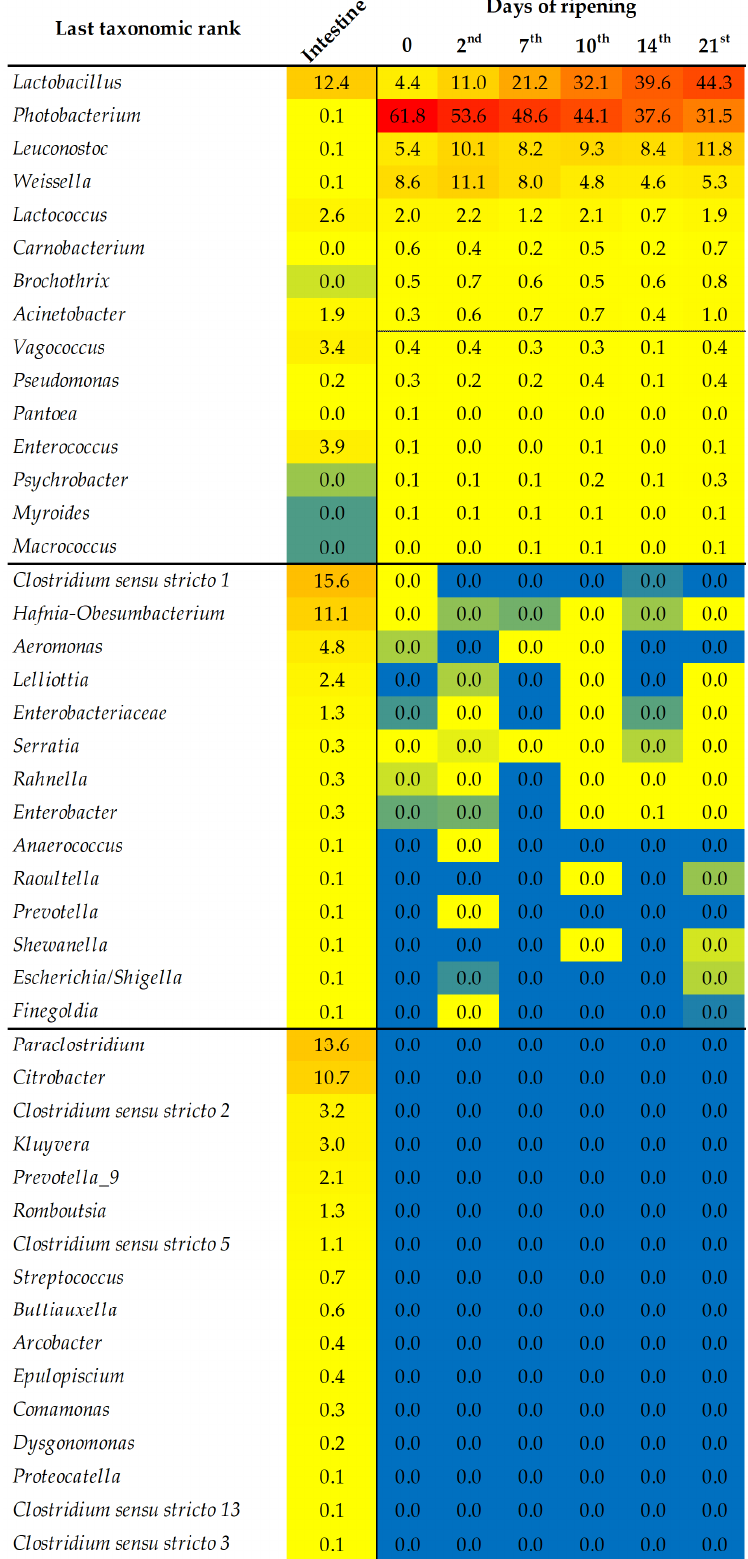
Figure 2. Relative abundance of bacterial taxa at the genus taxonomic rank according to the SILVA 132 database. Different colors indicate low or high abundance (blue, yellow, and red colors—lowest, medium, and highest RA).